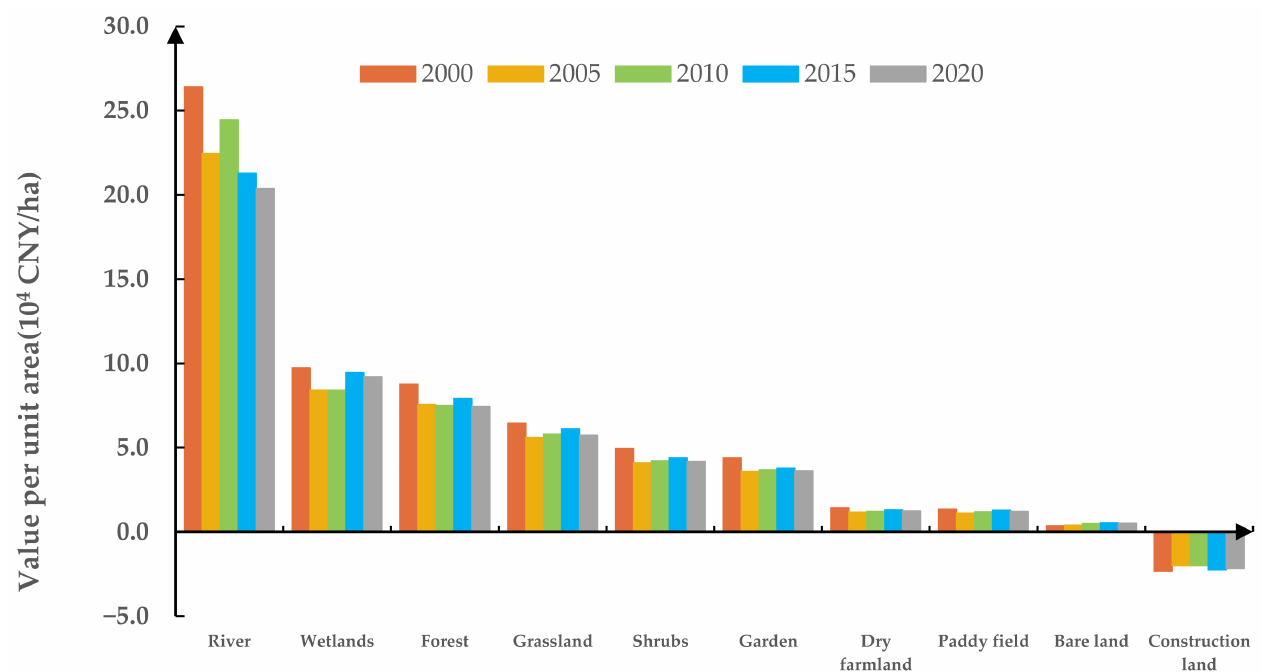
Figure 6. ESV value per unit area (CNY/ha) of ecosystem classes from 2000 to